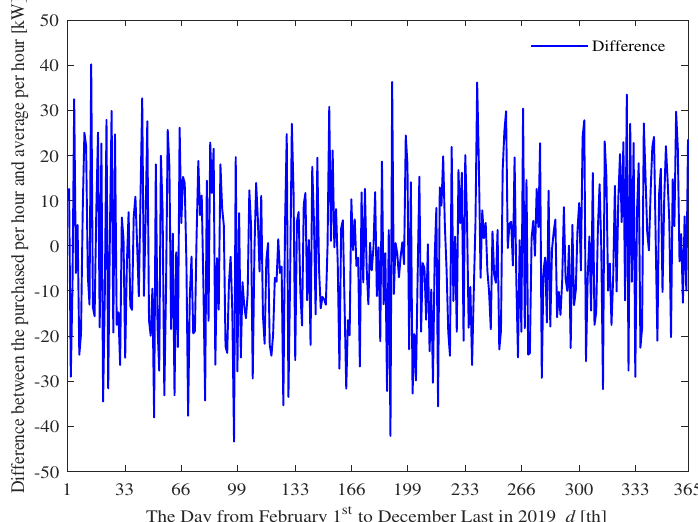
Figure 11. The disparity between the purchased power and the average daily power needed.